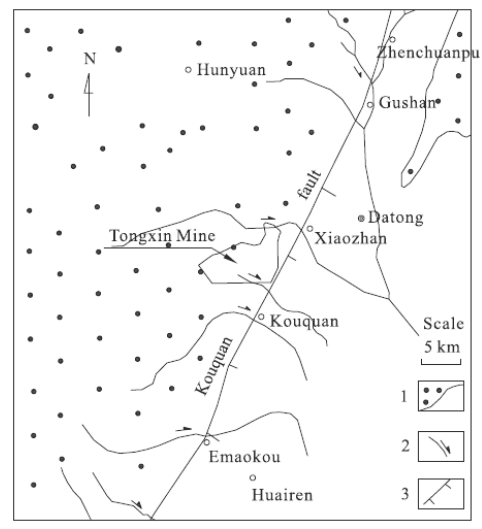
Figure 4: Holocene active segment spread of Kouquan fault.